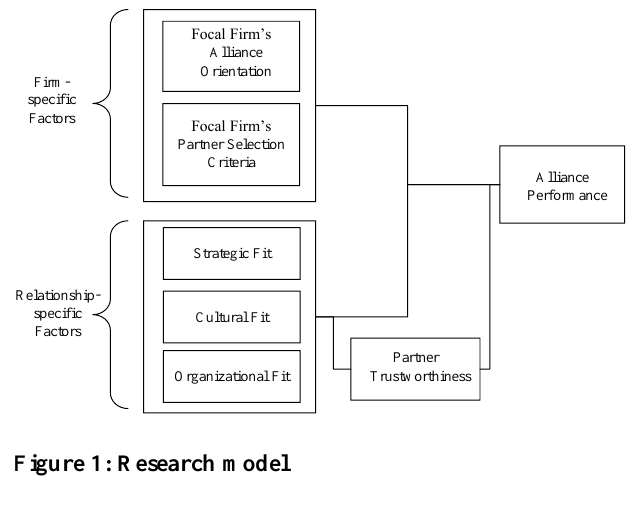
Figure 1: Research model